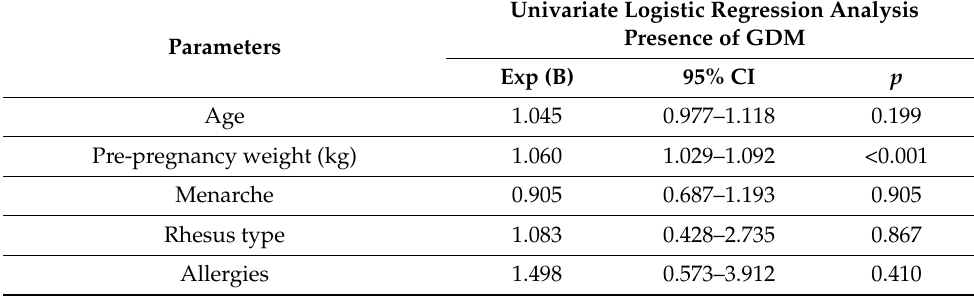
Table 3. Regression analysis of perinatal parameters characteristics due to the presence of gestational diabetes mellitus ( N =